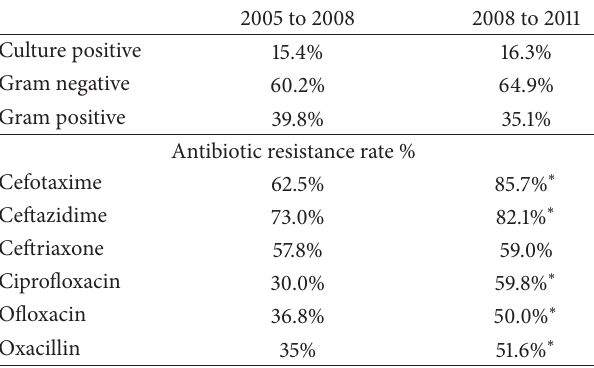
Table 3: Changes in the pattern of causative microorganism and the resistance rate to the first-line recommended antibiotics (2005–